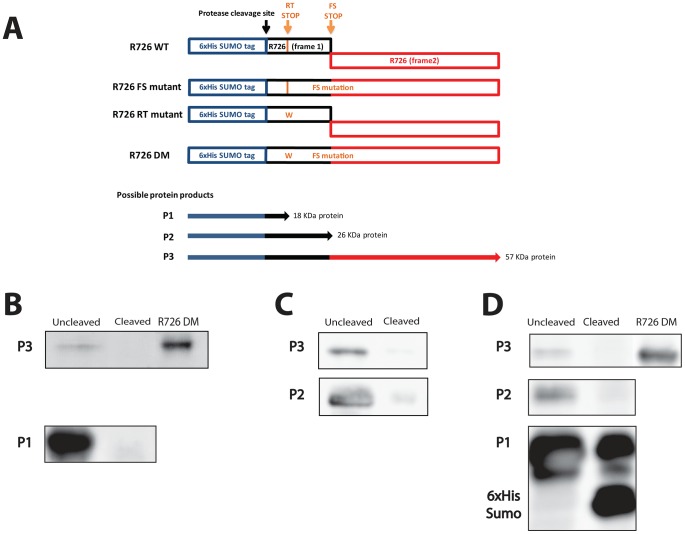
Schematic representation of the Mimivirus R726 gene constructs and Western blots.A) Schematic representation of the Mimivirus R726 gene constructs. The R726 WT construct is the wild-type gene in frame with a cleavable 6×His-SUMO tag (blue). The two R726 frames are symbolized by black and red boxes. The position of the Prescission cleavage site is depicted with a black arrow. The readthrough stop (RT stop) and the frameshift stop (FS stop) are symbolized by orange arrows. The R726 FS mutant construct exhibits a mutation at the FS stop to create a +1 translational frameshift. The RT stop in the R726 RT mutant construct was mutated by tryptophan substitution (see main text). The R726 DM double mutant construct exhibits both mutations to produce a full-length R726 protein. P1, P2 and P3 correspond to the three possibly expressed proteins from the constructs. The western blots show the expression of B) the P1 and P3 proteins from the R726 FS mutant construct, C) the P2 and P3 proteins from the R726 RT mutant construct and D) the P1, P2 and P3 proteins from the R726 WT construct. The P2 and P3 proteins are not detectable after cleavage of the tag with Prescission protease. Due to the large quantity of P1 protein, a fraction remains uncleaved after protease digestion and is still visible on the gel. The R726 DM gene product was used as a positive control for full-length R726 protein expression. Entire gels are shown in Figure S3.